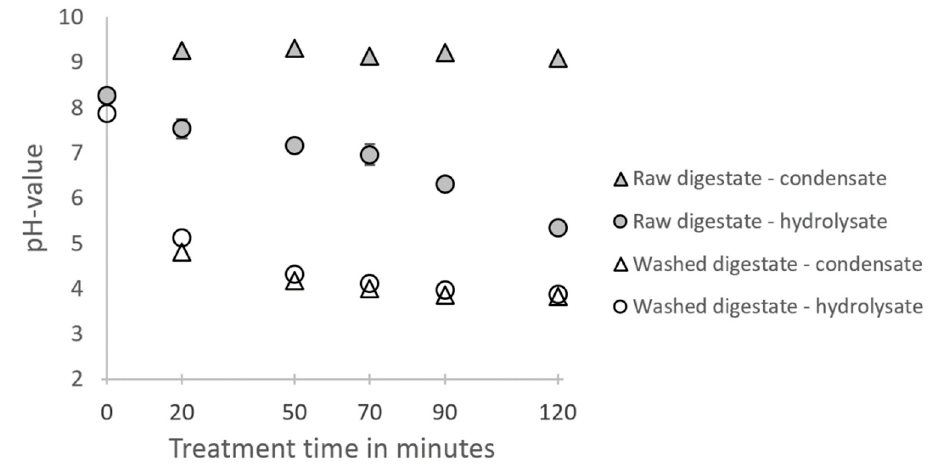
Figure 3. The pH-values of condensates and hydrolysates obtained from hydrothermal steam treatment of raw and washed digestate with varying treatment time (the standard deviation observed between two hydrothermal treatments performed at the same conditions was mostly less than 0.2 so that the error bars are mostly smaller than the data point).